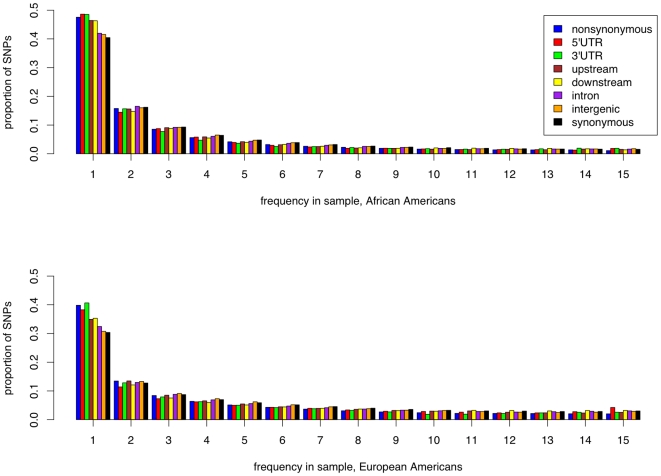
Allele frequency spectra for different classes of sites.Unfolded site frequency spectrum of nonsynonymous, synonymous, and conserved non-coding sites in 15 African Americans (above) and 20 European Americans (below); the data was re-sampled for 16 chromosomes to account for missing data. We used the chimpanzee to infer the ancestral state of each polymorphism, and corrected for ancestral misidentification using the method of Hernandez et al.
[64].